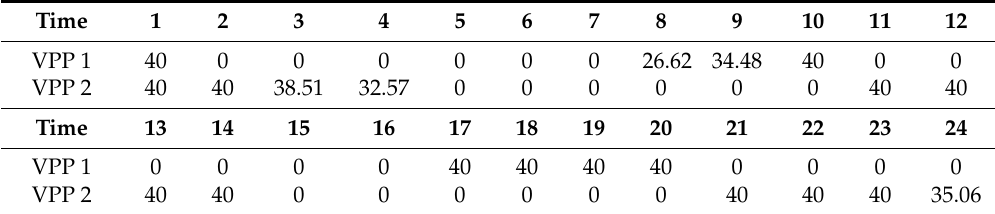
Table 1. Hourly optimal scheduling of VPPs in the modified six-bus test system.